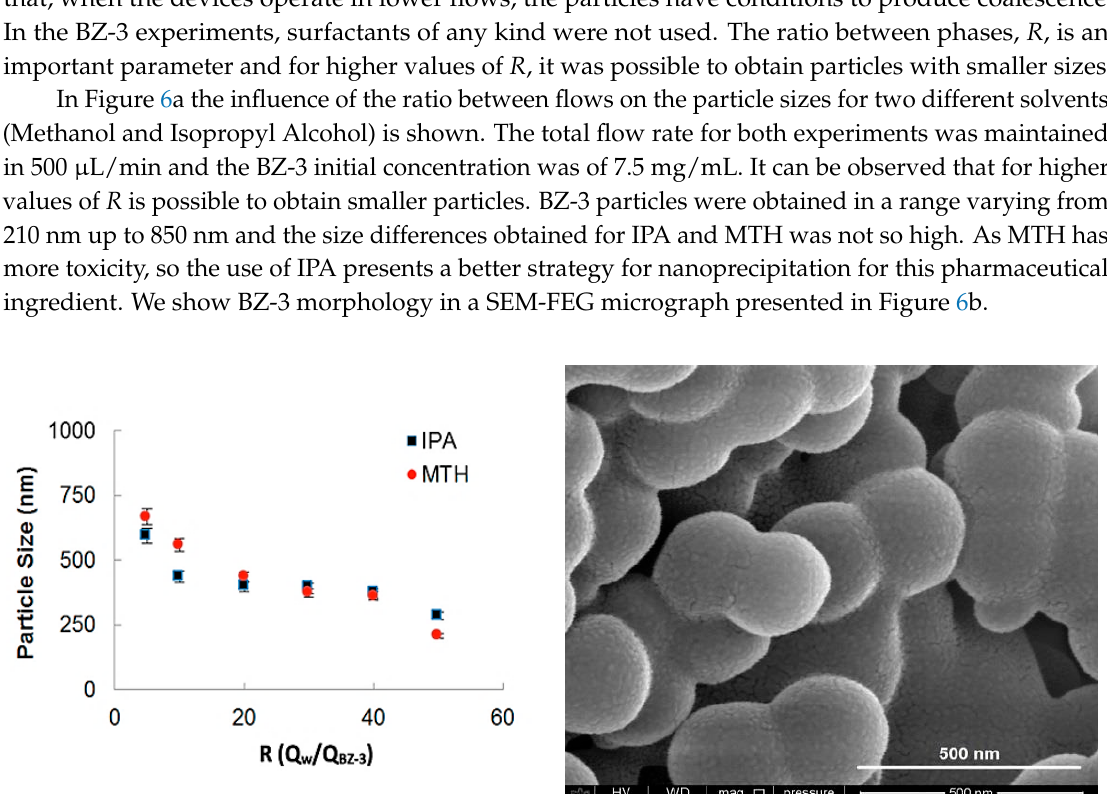
Figure 5. Benzophenone-3 particle size as a function of the ratio between fluid phases (water/BZ-3) for different total flow rates.